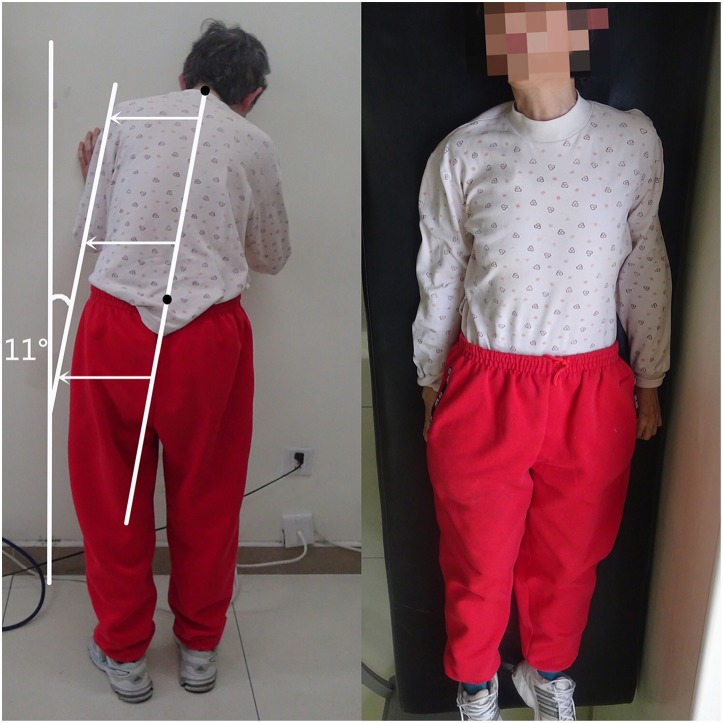
A PD patient with PS exhibited a lateral trunk flexion of 11° when standing and completely alleviated in the supine position. The written informed consent has been obtained from the individual for the publication of this image.